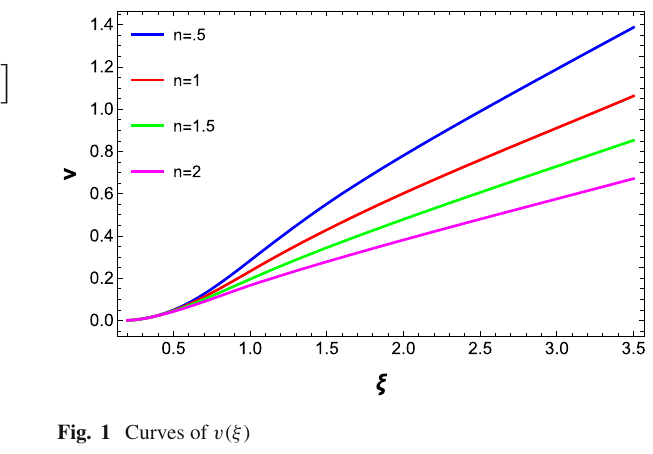
Fig. 1 Curves of